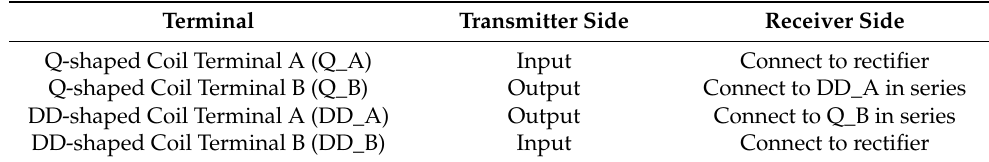
Table 1. The detailed coil connection method from this work.